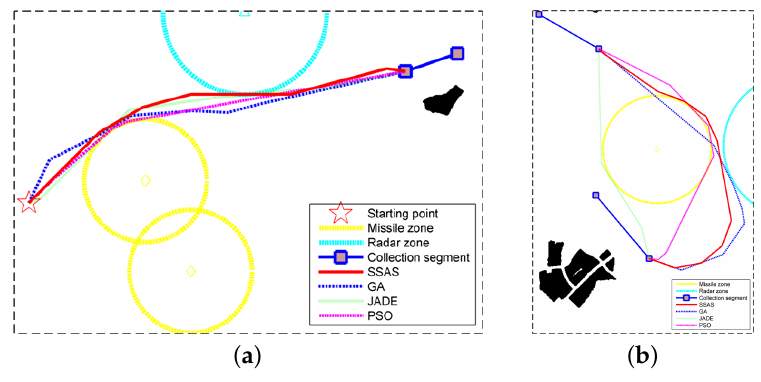
Figure 21. Sub-paths designed by different path planning algorithms. ( a ) test case 1-s1; ( b ) test case 1-s4.